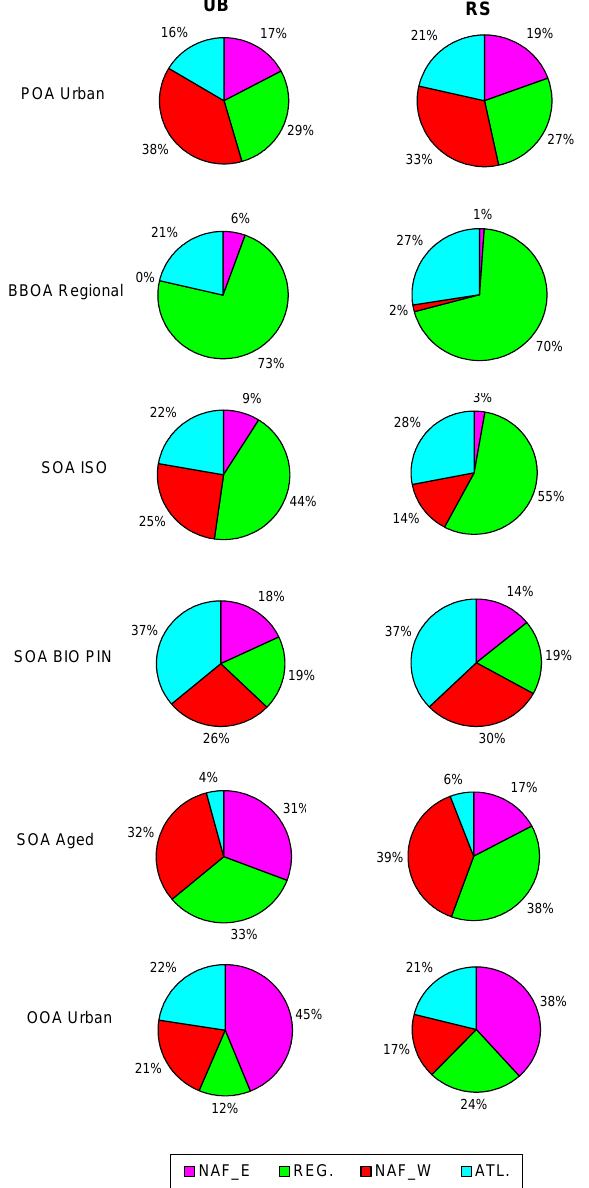
Fig. 3. Relative scores of the components in UB and RS in relation to the different air mass scenarios; NAF_W: North African air mass from the west; Atl.: Atlantic advection; REG.: regional air circula- tion; NAF_E: North African from the east over the Mediterranean Sea (Dall Osto et al.,